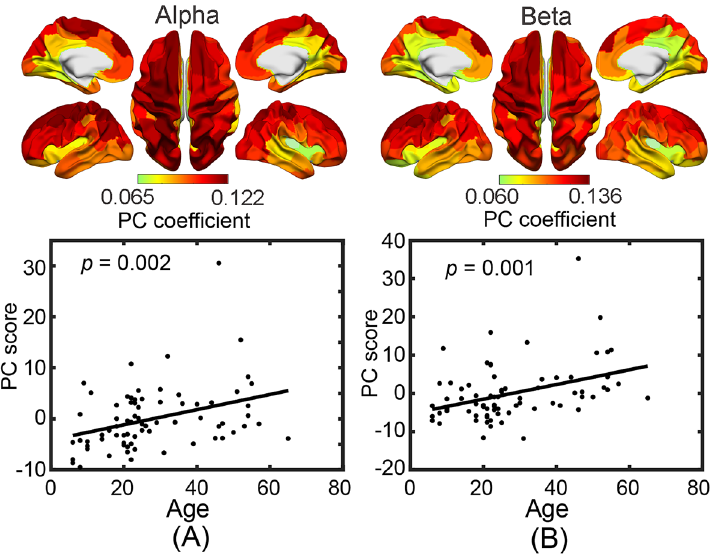
Figure 6. PCA-based age-related band-specific spectral power changes at the whole-brain scale. ( A ) Spatial map of PC coefficients (top) and PC scores (bottom) in the alpha band; ( B ) Spatial map of PC coefficients (top) and PC scores (bottom) in the beta band. The lines denote the linear regression models for PC scores, whose p values are listed (survived with Bonferroni